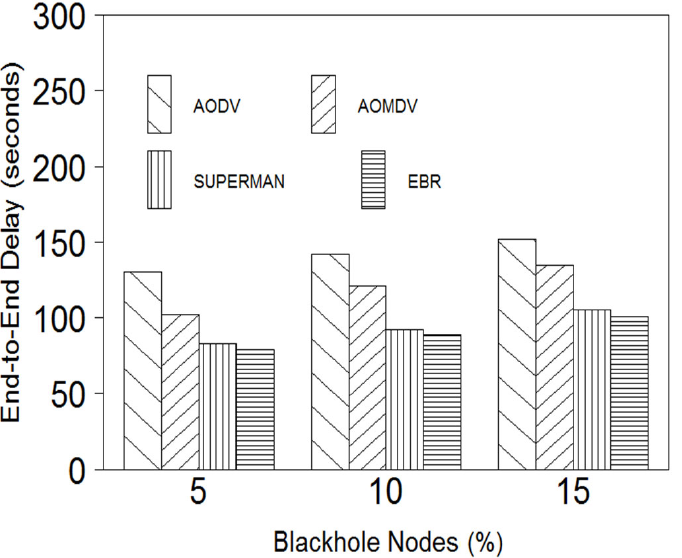
Figure 7. End ‐ to ‐ end delay vs. blackhole nodes percentage.